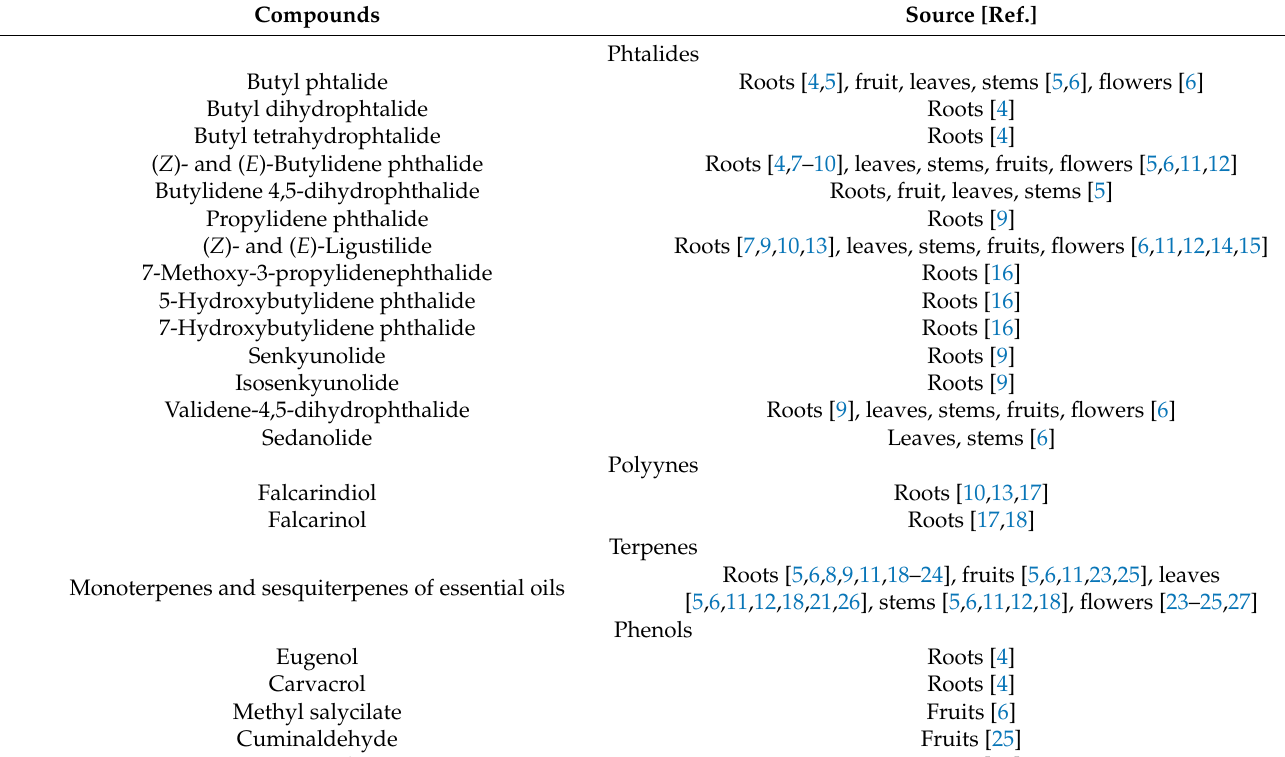
Table 1. Synopsis of known lovage ( Levisticum officinale )